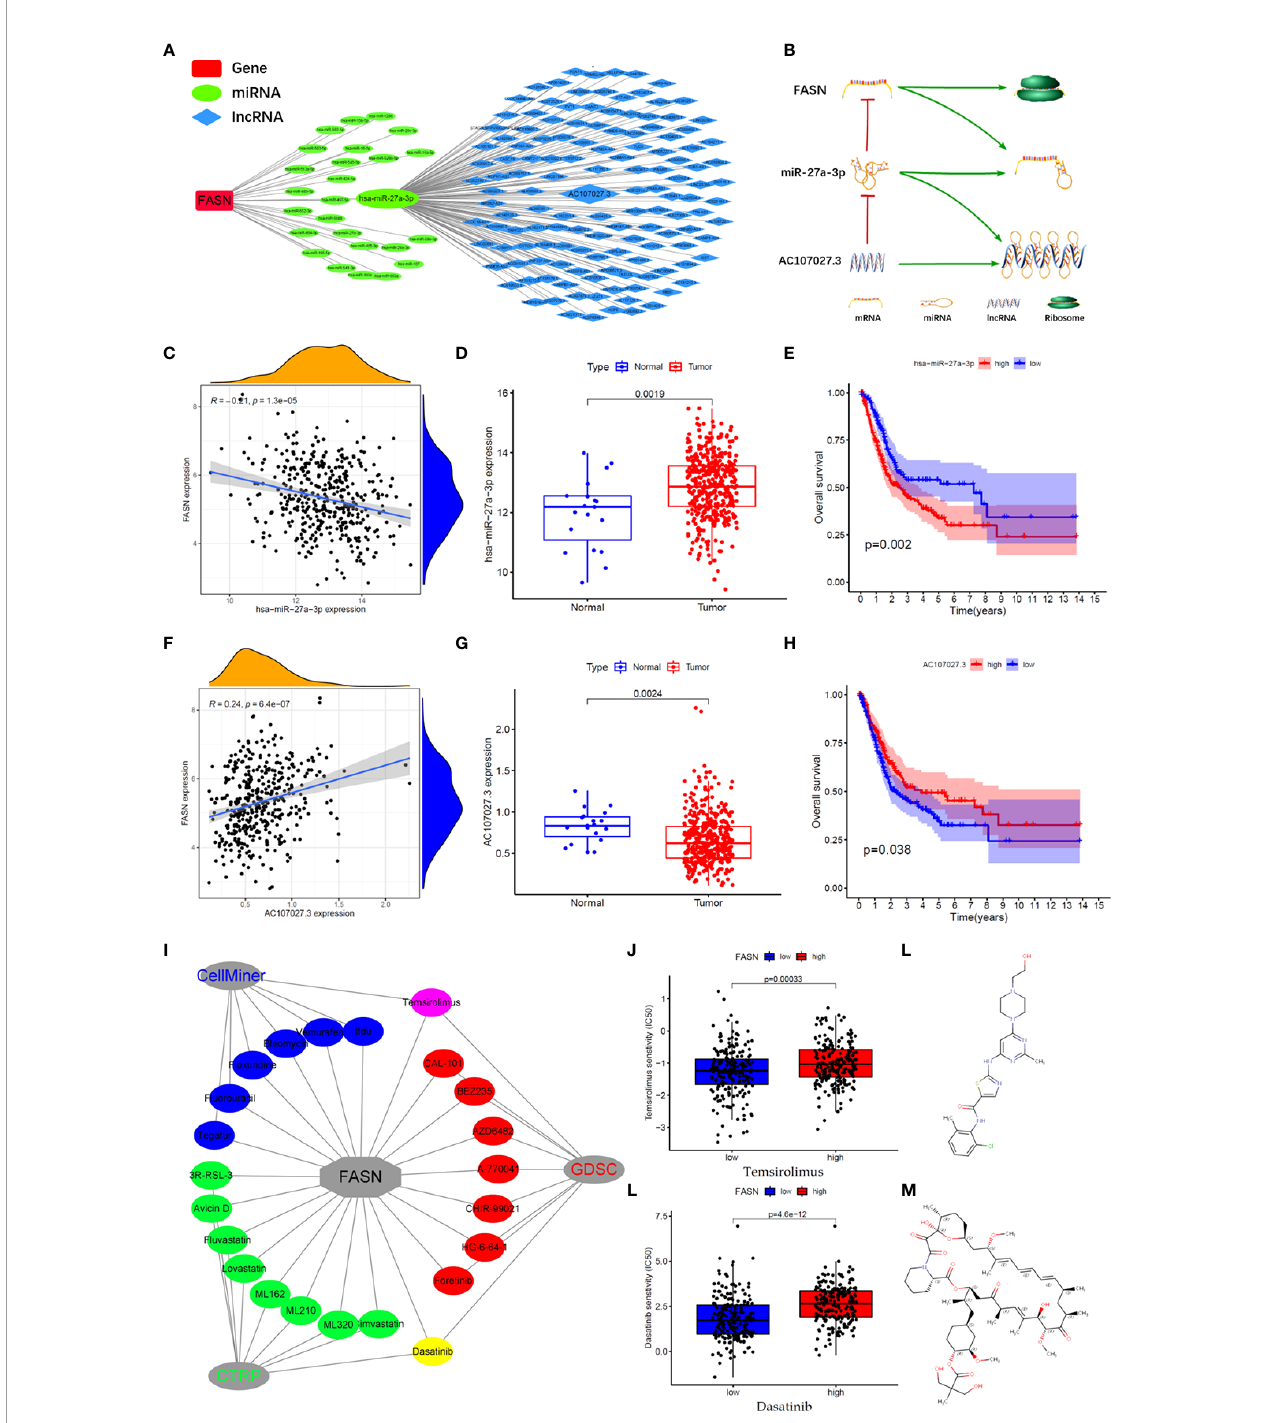
FIGURE 7 | CeRNA network and drugs prediction of FASN. (A) mRNA-miRNA-lncRNA interaction network of FASN in BC. (B) AC107027.3 competitively binds miR-27a-3p to decrease its inhibition on FASN. (C) Scatter plot of association between FASN and miR-27a-3p in TCGA. (D) Boxplot of miR-27a-3p in normal and tumor patients in TCGA. (E) Overall survival curve of low- and high- miR-27a-3p groups in TCGA. (F) Scatter plot of association between FASN and AC107027.3 in TCGA. (G) Boxplot of AC107027.3 in normal and tumor patients in TCGA. (H) Overall survival curve of low- and high- AC107027.3 groups in TCGA. (I) Drugs targeting FASN in the CTRP, GDSC, and CellMiner databases. (J, K) IC50 of dasatinib and temsirolimus in low- and high-FASN groups. (L, M) Chemical structure of dasatinib and temsirolimus from